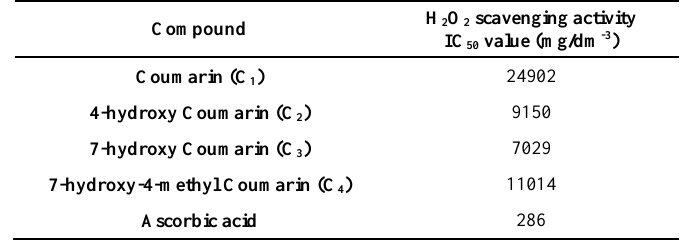
Table 1. IC 50 value for H 2 O 2 scavenging activity of tested coumarins and Ascorbic acid